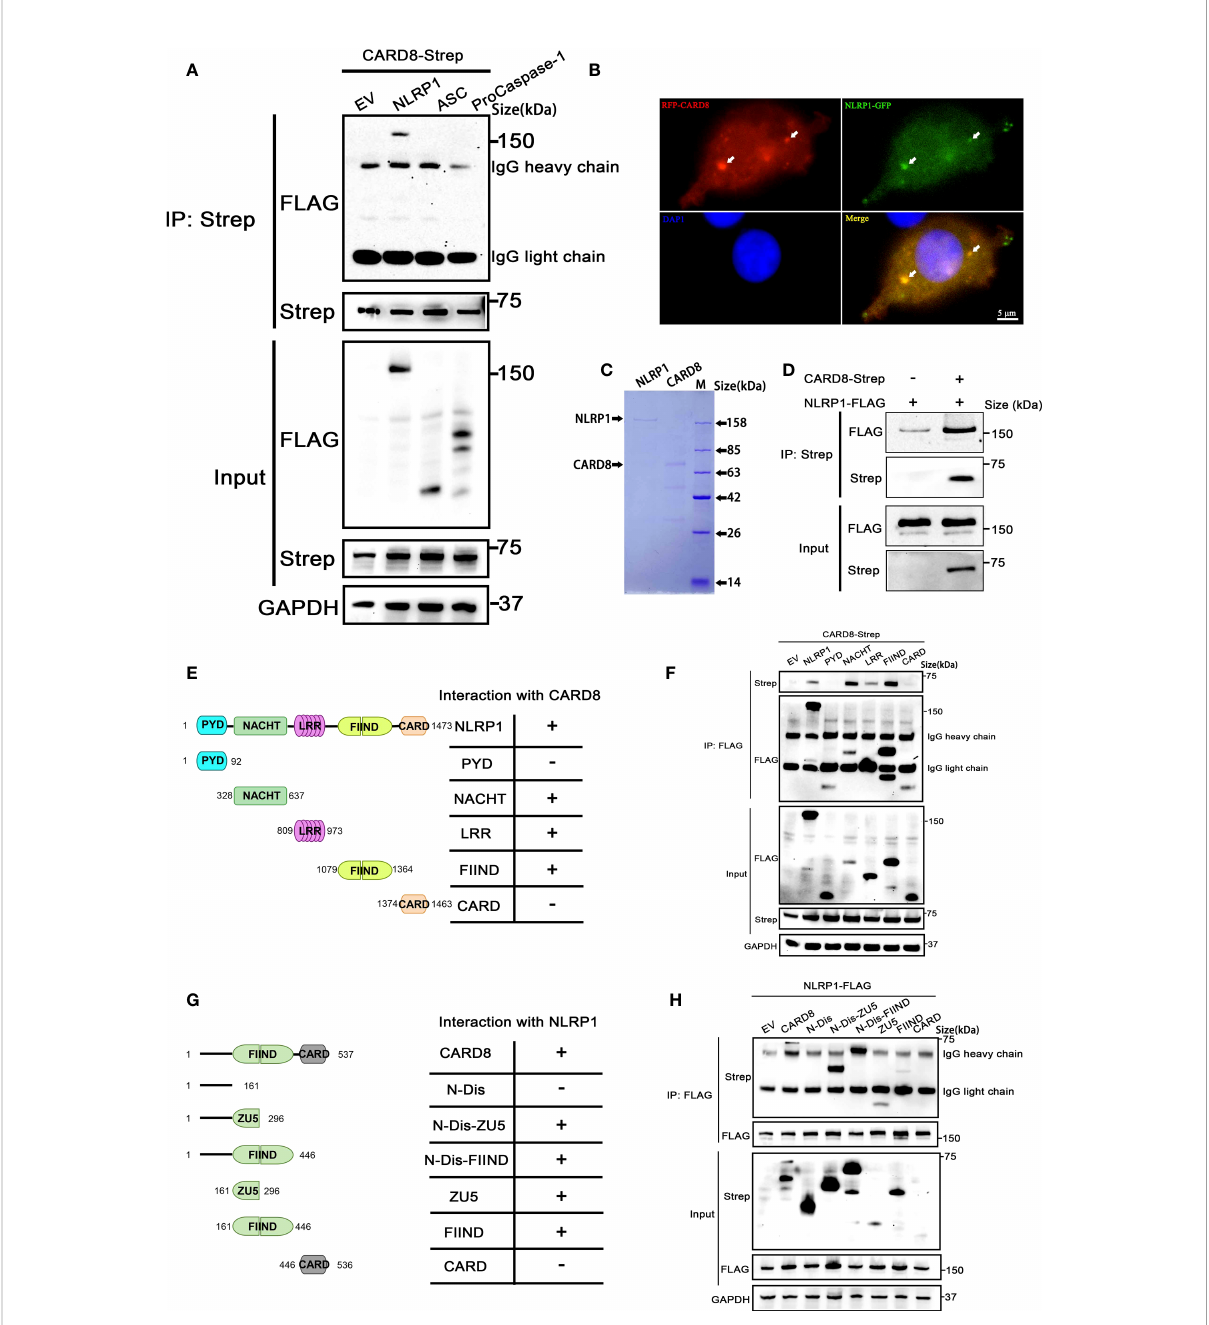
FIGURE 3 CARD8-T60 co-localizes and directly interacts with NLRP1. (A) HEK 293T cells were transiently transfected with constructs for empty vector (EV), NLRP1-FLAG, ASC-FLAG, proCaspase-1-FLAG and CARD8-T60-Strep. After 28 hours, the protein expression was detected by immunoblotting, and co-immunoprecipitation were conducted with anti-Strep antibody to analyze the interaction. (B) Transient transfection RFP-CARD8 and NLRP1-GFP in HEK 293T cells. Green and red fl uorescent were captured by fl uorescence microscopy. Co-localization regions are labeled with white arrow. (C) The SDS-PAGE analysis of recombinant NLRP1 and CARD8 proteins. (D) Pull down assay of puri fi ed NLRP1- FLAG and CARD8-Strep proteins in vitro . (E) Diagrammatic representation of truncation mutants of NLRP1. (F) HEK 293T cells were transiently transfected with constructs for empty vector (EV), NLRP1-FLAG, NLRP1-FLAG truncation mutants and CARD8-T60-Strep. After 28 hours, the protein expression was detected by immunoblotting, and co-immunoprecipitation were conducted with anti-FLAG antibody to analyze the interaction. (G) Diagrammatic representation of truncation mutants of CARD8-T60. (H) HEK 293T cells were transiently transfected with constructs for empty vector (EV), CARD8-T60-Strep, CARD8-T60-Strep truncation mutants and NLRP1-FLAG. After 28 hours, the protein expression was detected by immunoblotting, and co-immunoprecipitation were conducted with anti-FLAG antibody to analyze the